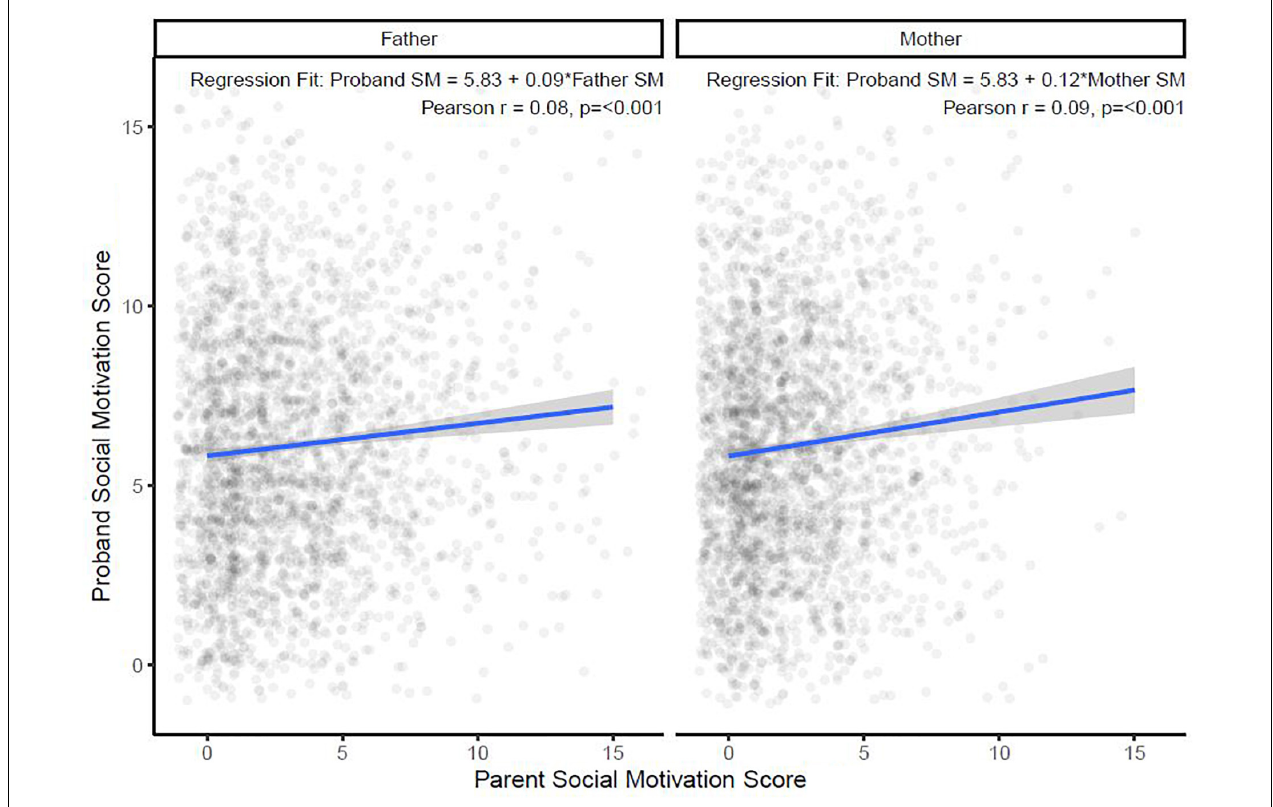
FIGURE 2 | Relationship between paternal and maternal social motivation scores with autistic children’s with social motivation scores. SM, social motivation.